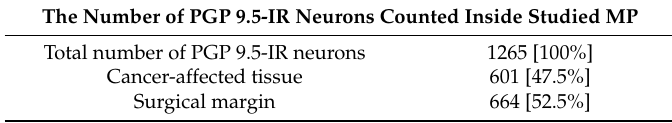
Table 1. The number of protein gene-product 9.5-immunoreactive (PGP 9.5-IR) neurons counted inside studied myenteric plexi (MP) located in the cancer-affected wall and wall distal from cancer invasion. Data were pooled and presented as the representative populations for 10